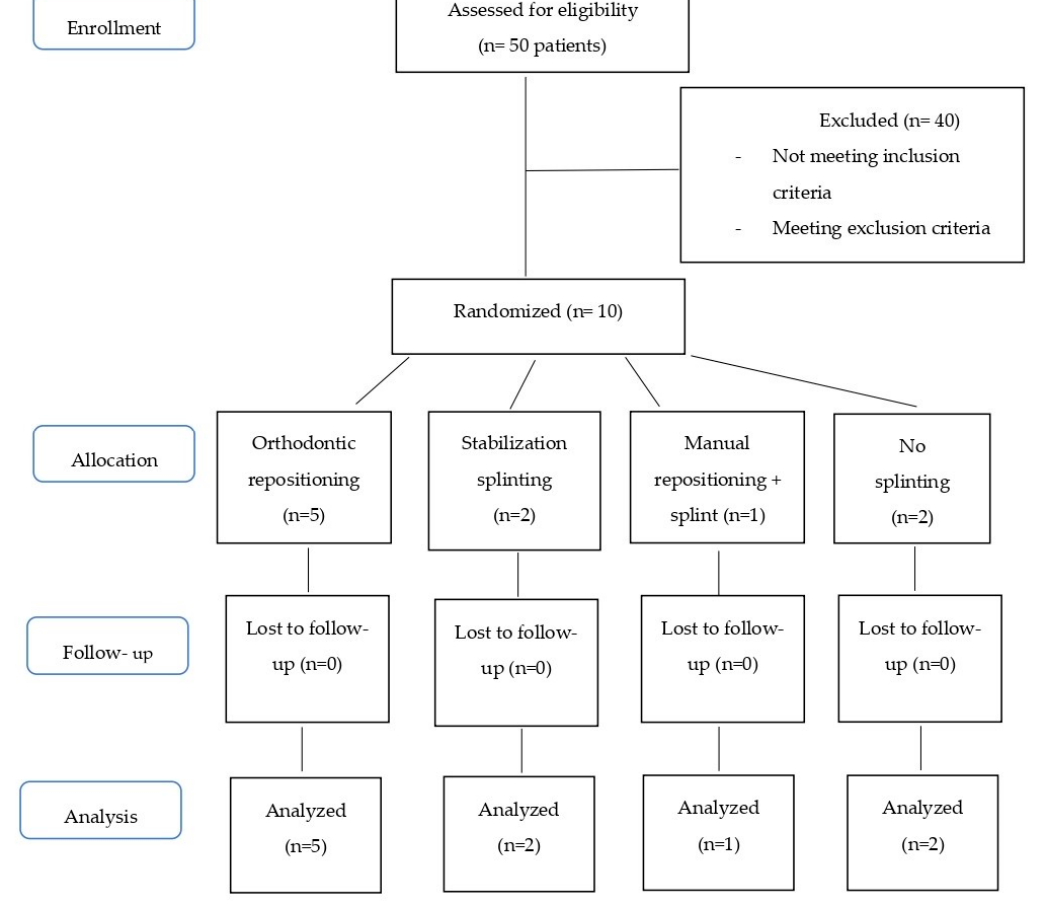
Figure 3. Flow diagram showing the phases of the study: enrollment, allocation, follow-up, analysis.